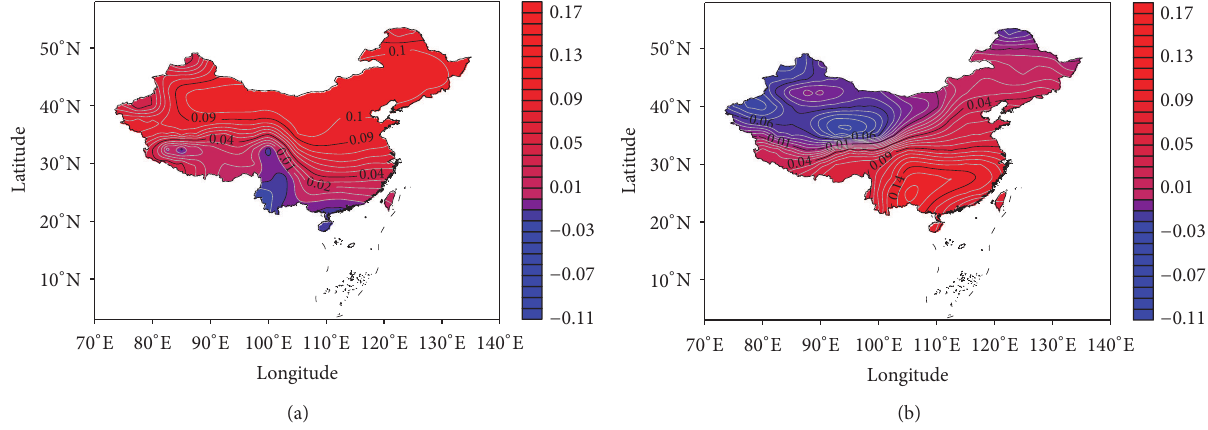
Figure 4: Distribution pattern of the (a) first and (b) second eigenvector of